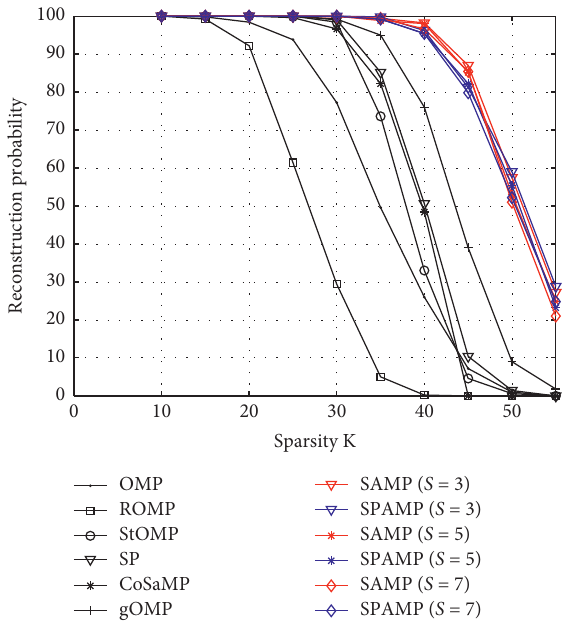
Figure 4: Probability of exact recovery versus the signal sparsity ( M � 128).